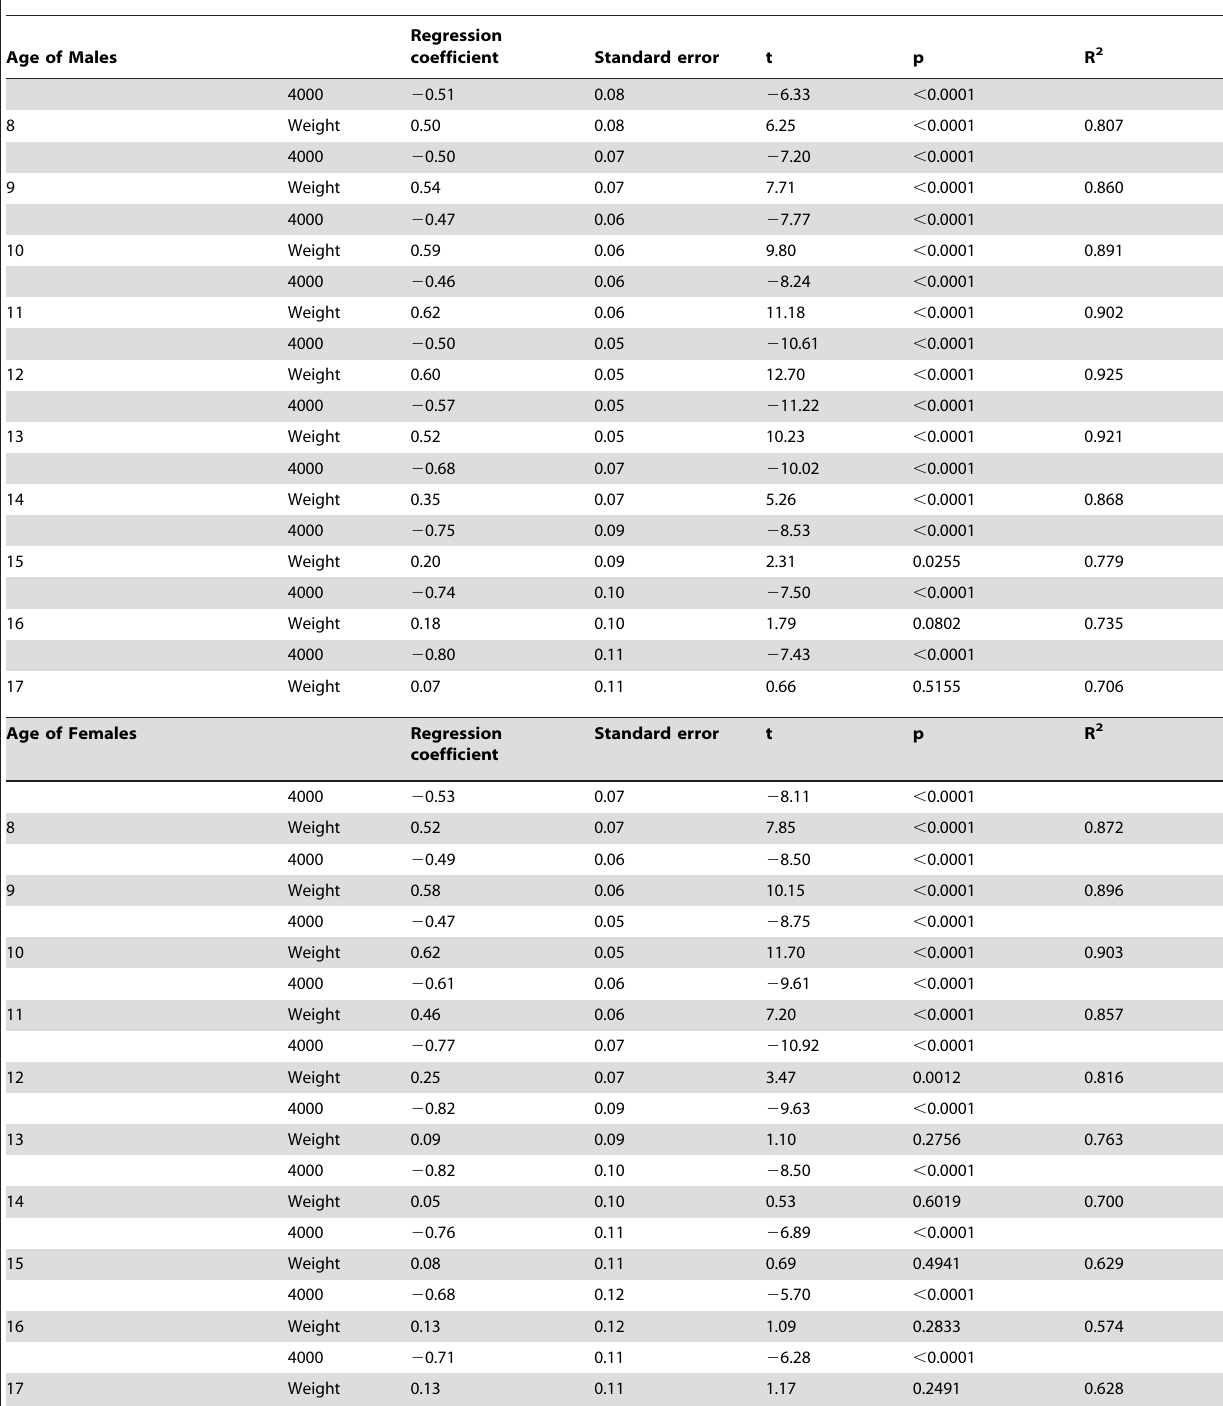
Table 8. Regression coefficients (standard errors) of predictors of height.